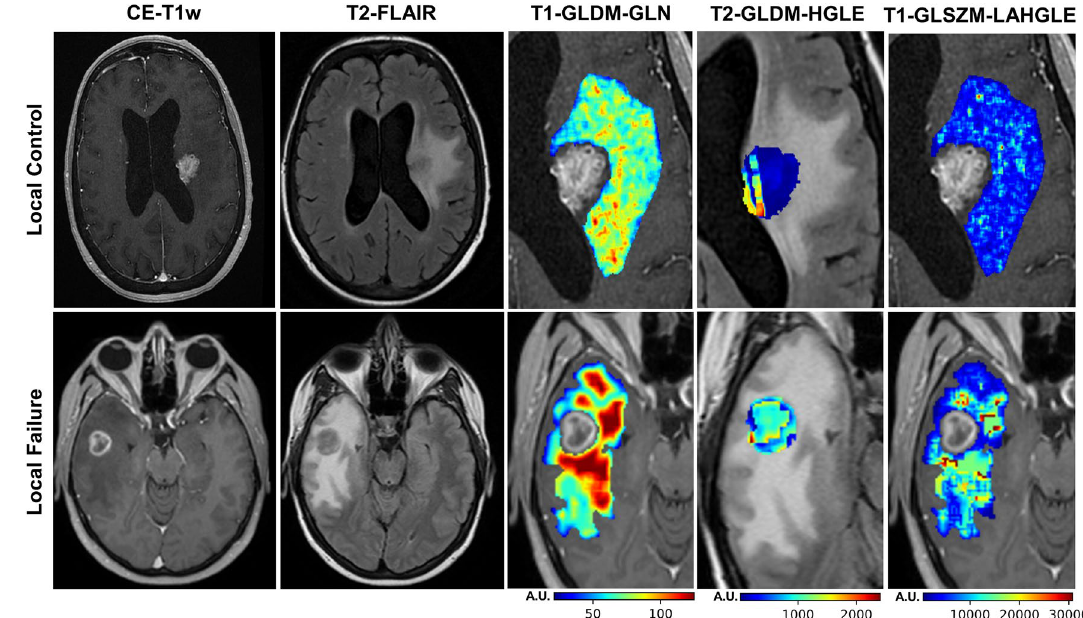
Figure 3. CE-T1w and T2-FLAIR images and parametric maps of the texture features in the optimal quantitative MRI biomarker for two representative lesions with LC and LF outcomes after SRT.